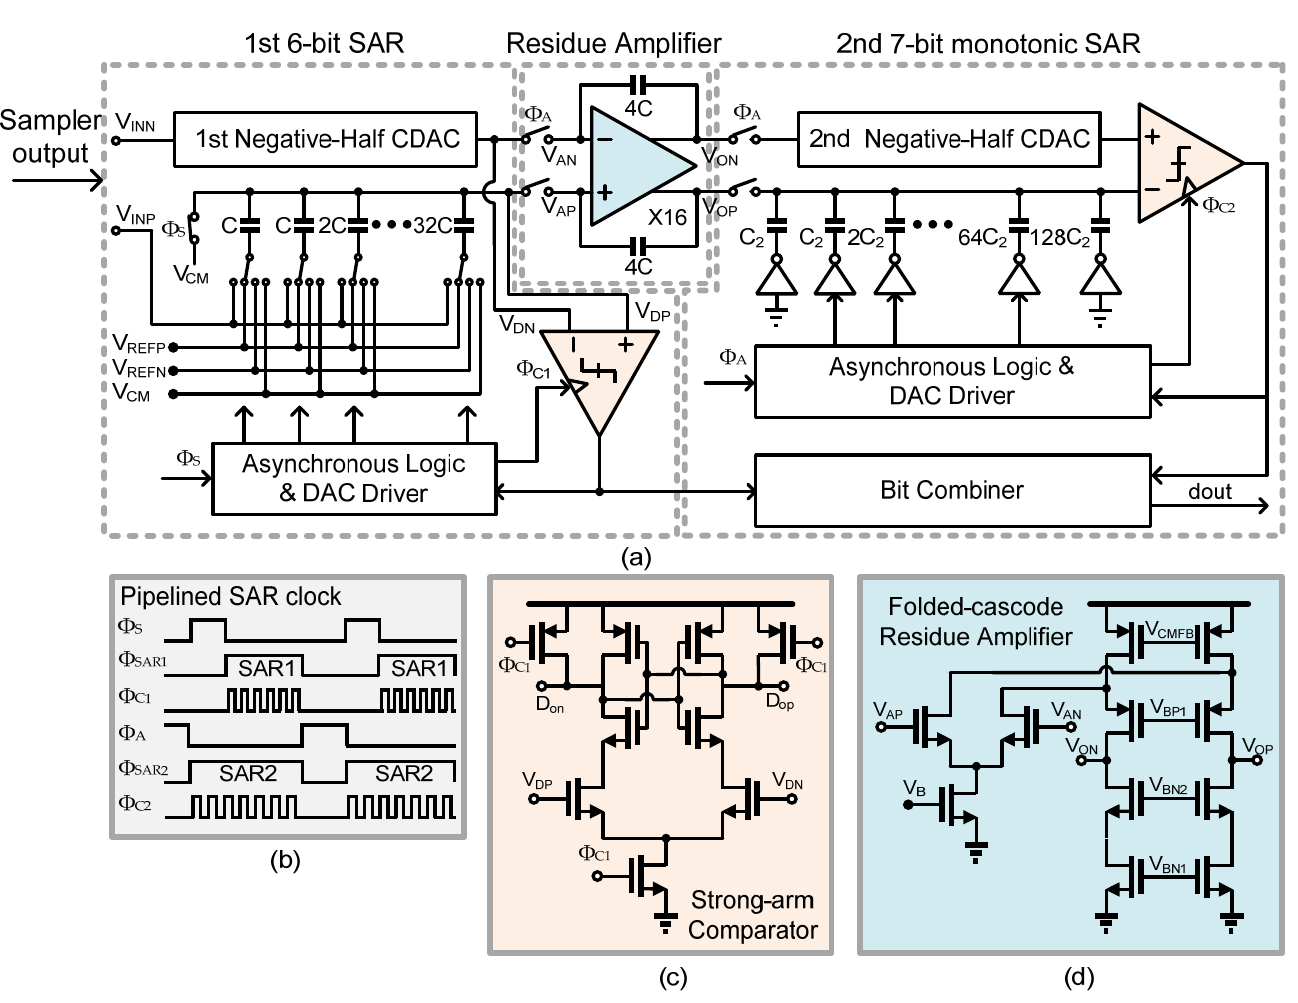
Figure 5. ( a ) The architecture of the 12-bit pipelined SAR ADC. ( b ) The clock diagram of the pipe- lined SAR ADC. ( c ) The comparator. ( d ) The stage residue amplifier using a folded-cascode struc-